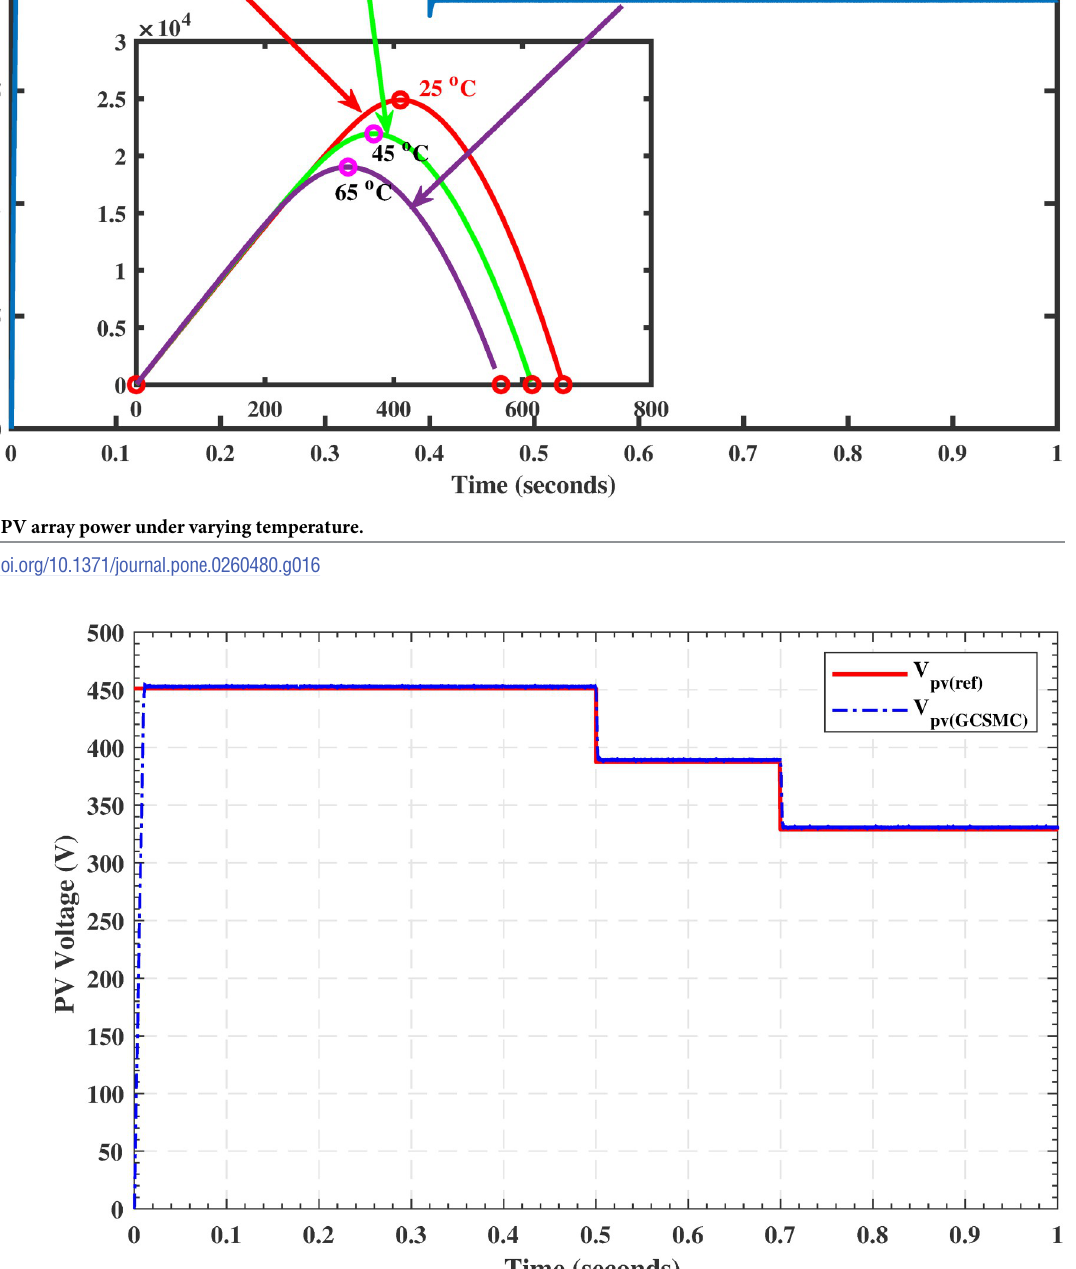
PLOS ONE | https://doi.org/10.1371/journal.pone.0260480 January 20,